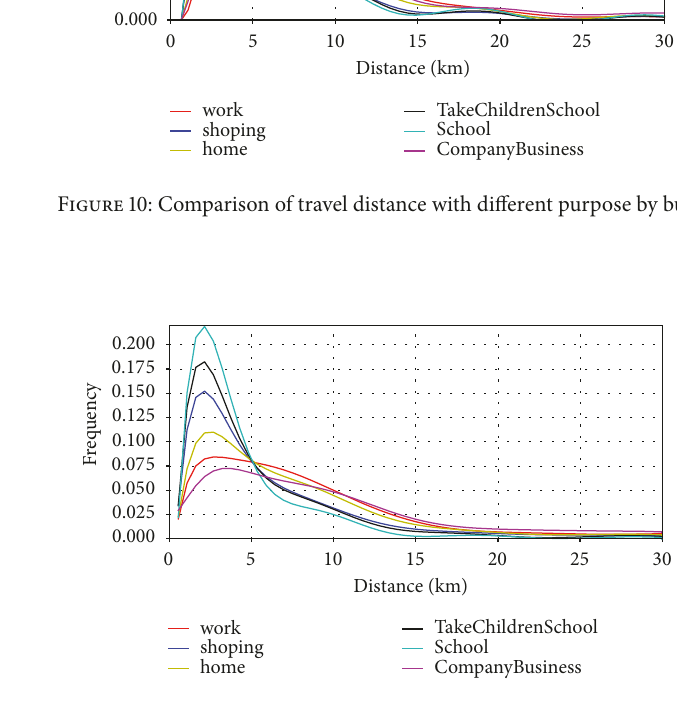
Figure 11: Comparison of travel distance with different purpose by